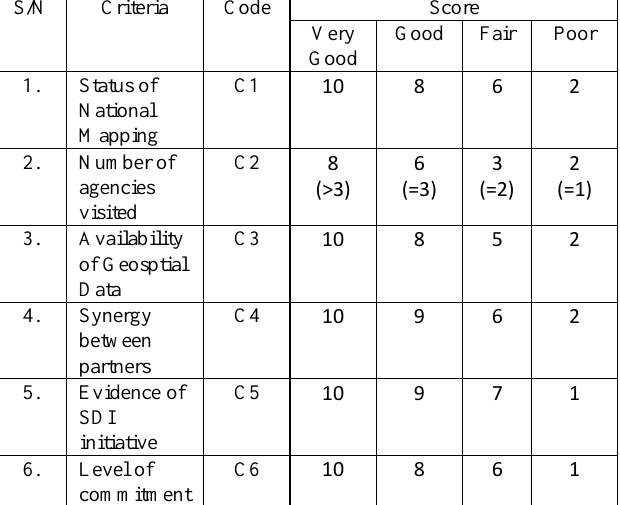
Table 1. : Scoring sheet of geospatial performance criteria